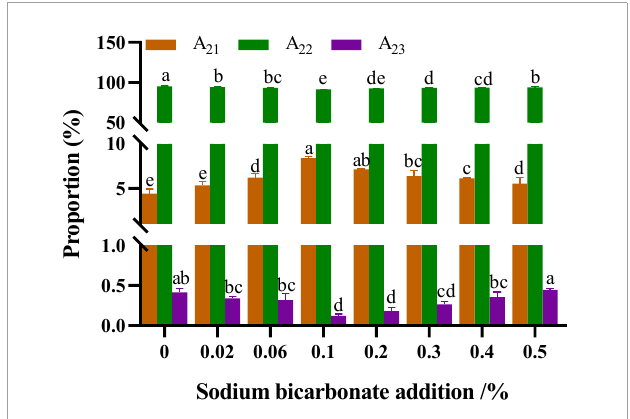
FIGURE5 Effect of sodium bicarbonate on the moisture distribution of semi-dried rice noodles. Means of the same parameter with different superscript letters indicate significant difference ( p <